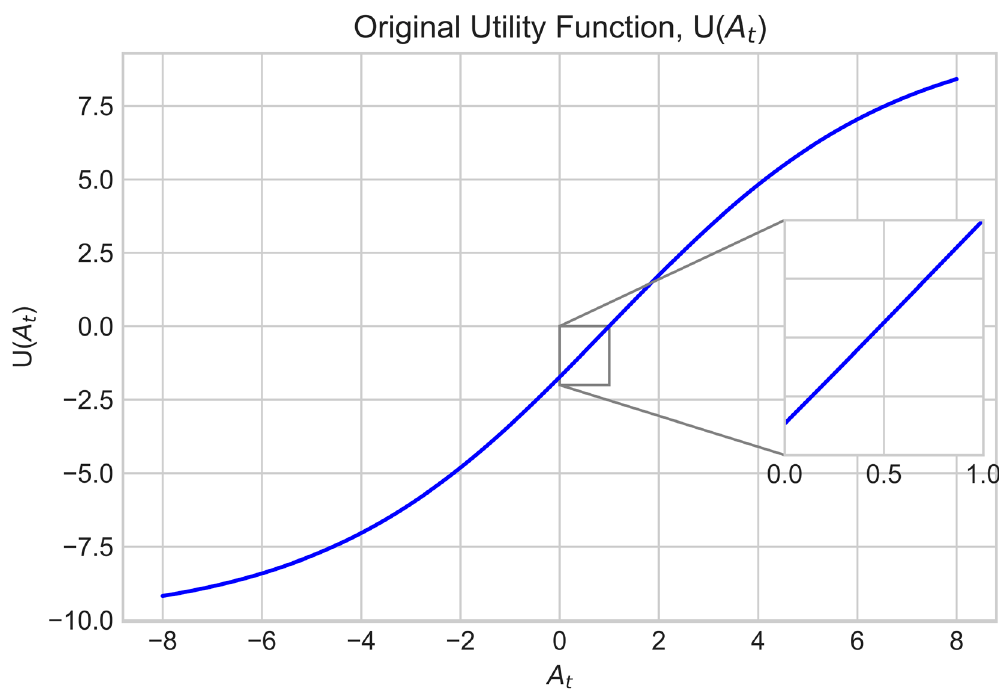
Figure 5. The original utility function U ( A t ) can be approximated as a straight line when A t falls in the range [0, 1].